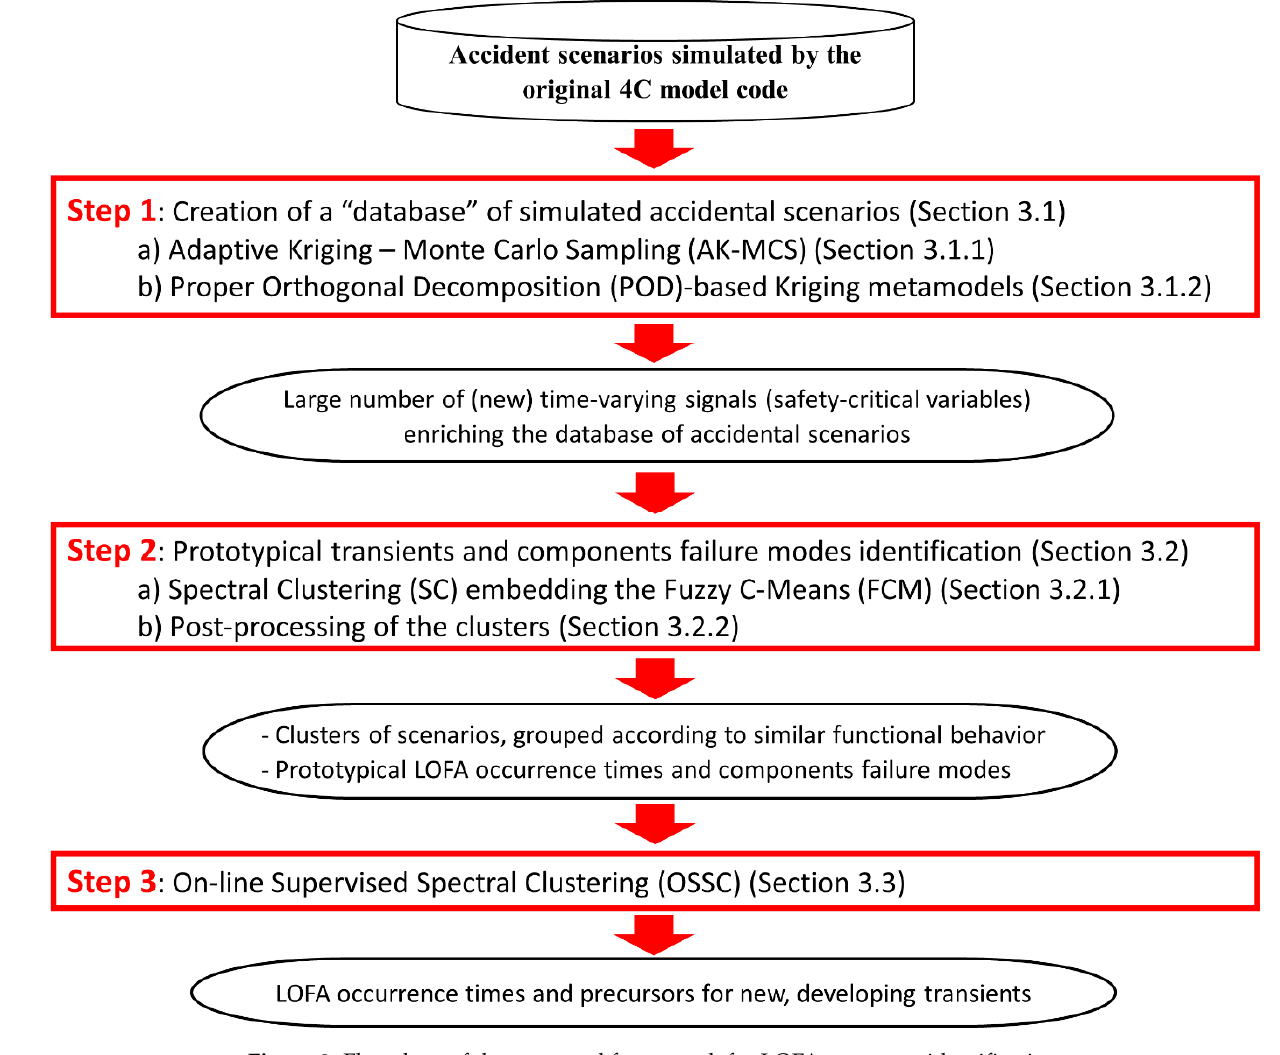
Figure 2. Flowchart of the proposed framework for LOFA precursor identification.